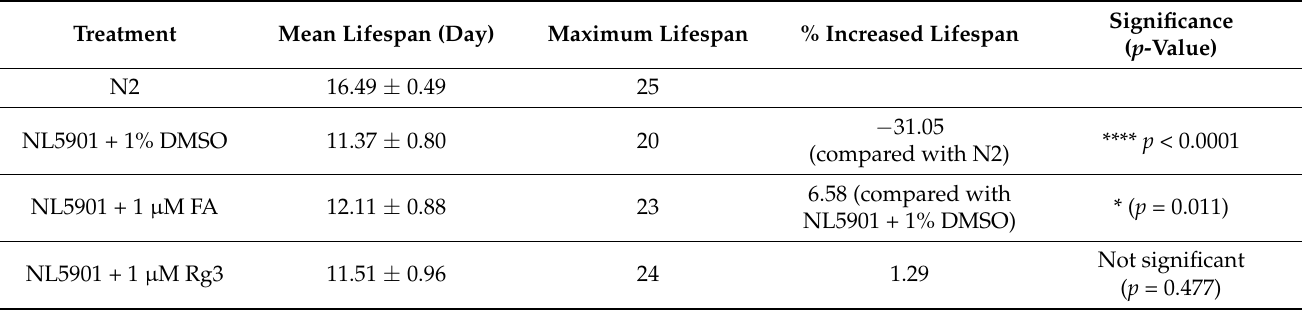
Table 2. Mean lifespan, maximum lifespan, percentage of increased lifespan and significant p values of N2 and NL5901 worms treated with FA and